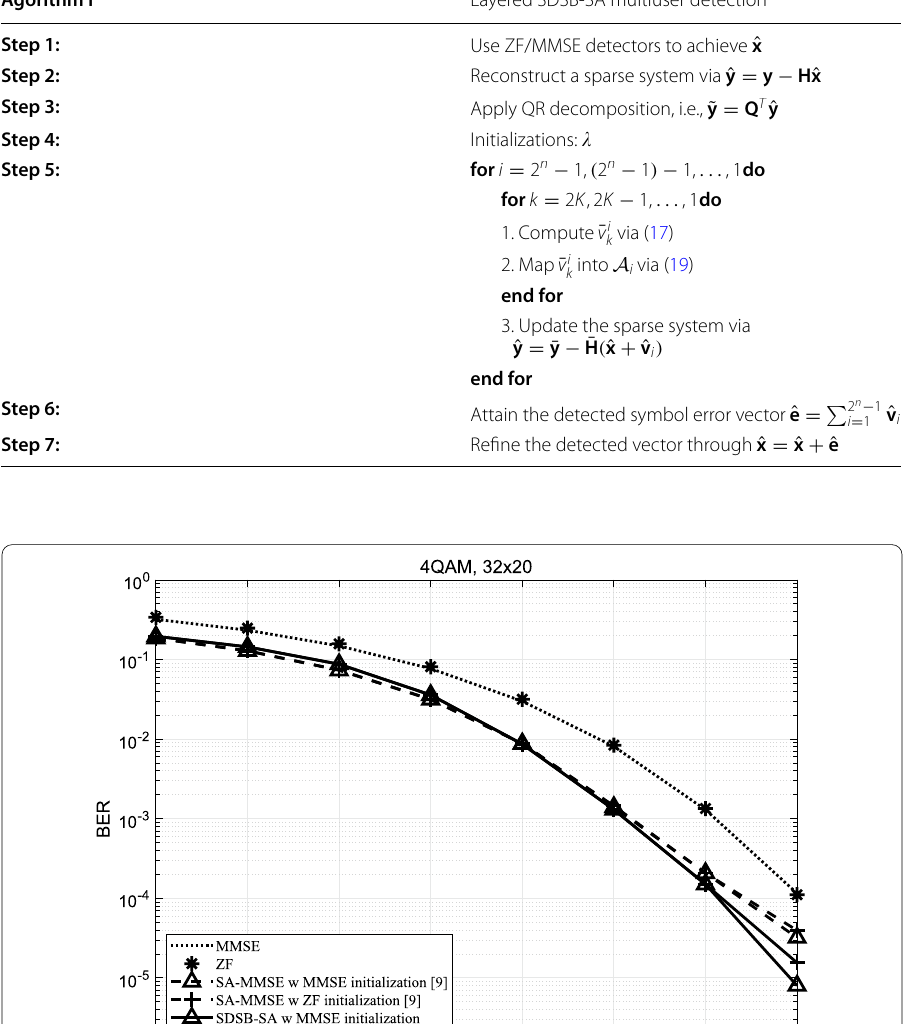
SA-MMSE and MMSE/ZF +